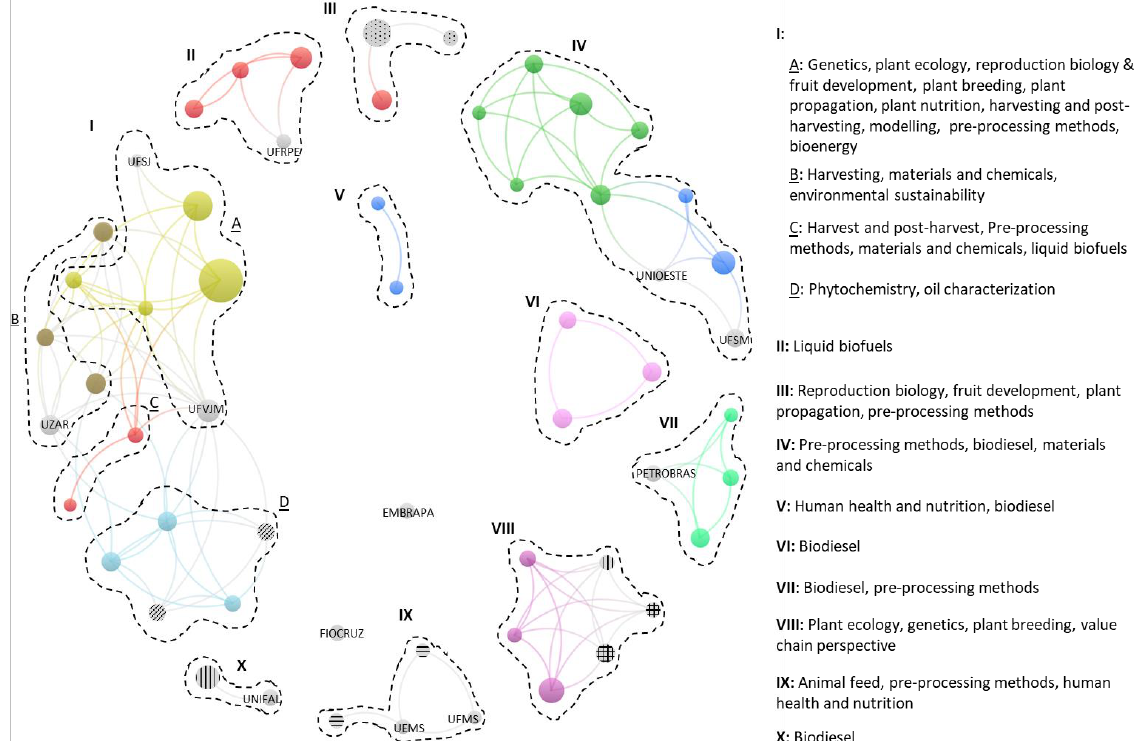
Figure 2. Research networks and foci of leading acrocomia researchers. Colors indicate affiliation, size of nodes correspond to researcher’s SJR, and interactions depict co-authorship. Affiliations: red: Federal University of Minas Gerais (UFMG); green: Federal University of Santa Catarina (UFSC); yellow: Federal University of Viçosa (UFV); dark blue: State University of Maringá (UEM); purple: Agronomical Institute of Campinas (IAC); light blue: Institute of Natural Resources and Agrobiology of Seville (IRNAS); light green: Federal University of Rio de Janeiro (UFRJ); pink: University of Campinas (UNICAMP); brown: University of Valladolid (UNIVALL); gray ( ⸭ ): State University of Montes Claros (UNIMONTES); gray (#): São Paulo’s Agency for Agribusiness Technology (APTA); gray ( ≡ ): Federal University of Grande Dourados (UFGDM); gray (|||): University of São Paulo (USP); gray (///): University of Wisconsin-Madison (UWISC), gray: Federal University of São João del-Rei (UFSJ), Federal University of Vales do Jequitinhonha e Mucuri (UFVJM), University of Zaragoza (UZAR), Federal Rural University of Pernambuco (UFRPE), Federal University of Alfenas (UNIFAL), Mato Grosso do Sul State University (UEMS), Federal University of Mato Grosso do Sul (UFMS), Western Paraná State University (UNIOESTE), Federal University of Santa Maria (UFSM), Brazilian Agricultural Research Corporation (EMBRAPA), Oswaldo Cruz Foundation (FIOCRUZ). Covered period of analysis: 1878 (first acrocomia-related publication retrieved from Scopus) – 2018.